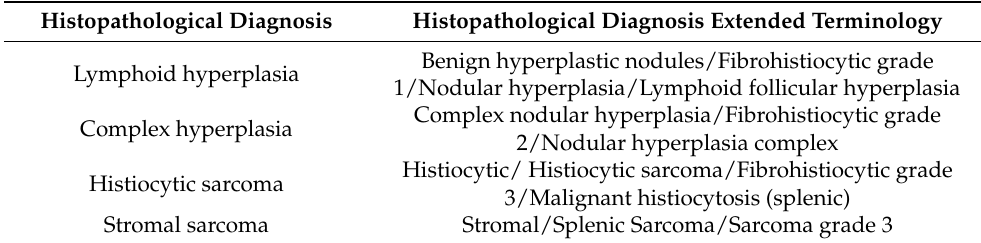
Table 1. Key histopathology terms from free-text clinical notes used to classify fibrohistiocytic nodules into the four distinct